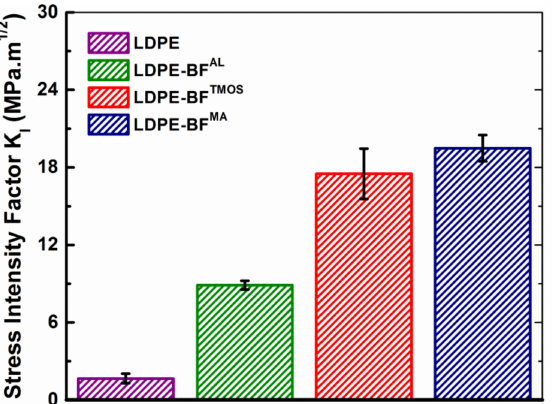
Figure 8. Variation in mode I stress intensity factor ( K I ) of LDPE and LDPE-BFs composite sheets vis- à -vis BFs chemical treatment.